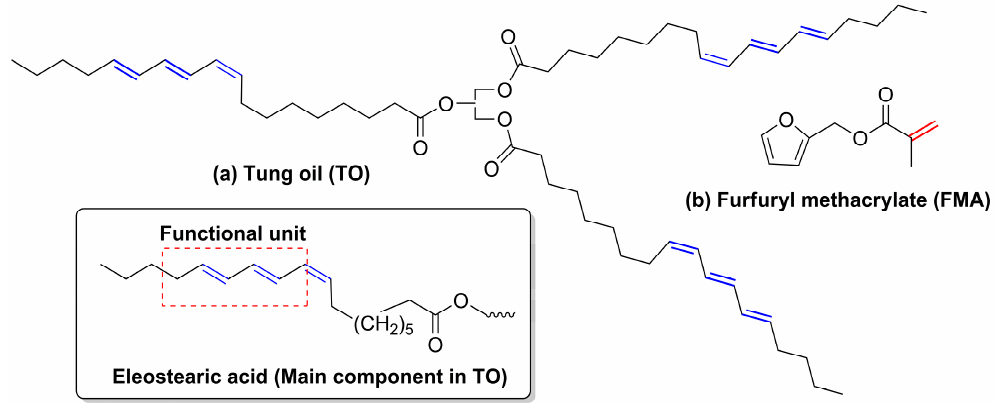
Figure 1. The chemical structure of vegetable oil and acrylate monomer: ( a ) tung oil (TO) and ( b ) furfuryl methacrylate (FMA).